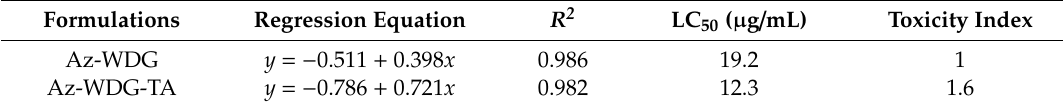
Table 2. Antifungal activities of Az-WDG and Az-WDG-TA against Fusarium oxysporum.